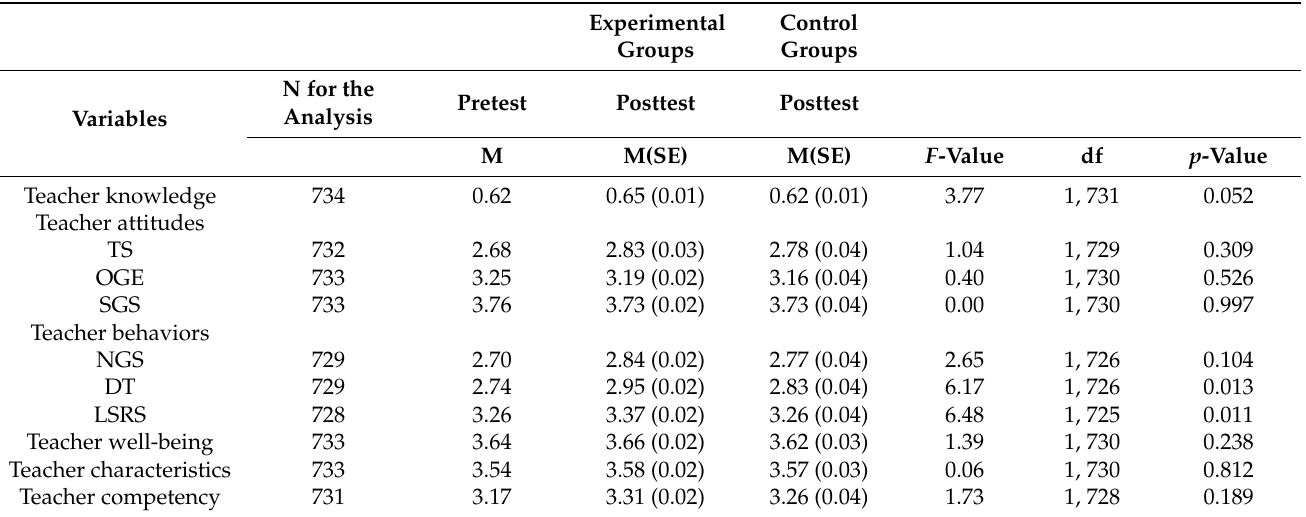
Table 7. Results of one-way ANCOVA on the outcome variables for teachers in the experimental and control